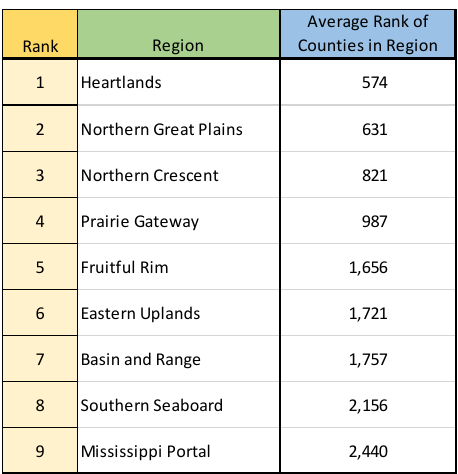
Table 13. Region Ranking: Wage as Percent of Federal Minimum, 2012 Map 12. Wage as Percent of Federal Minimum Rank, 2012